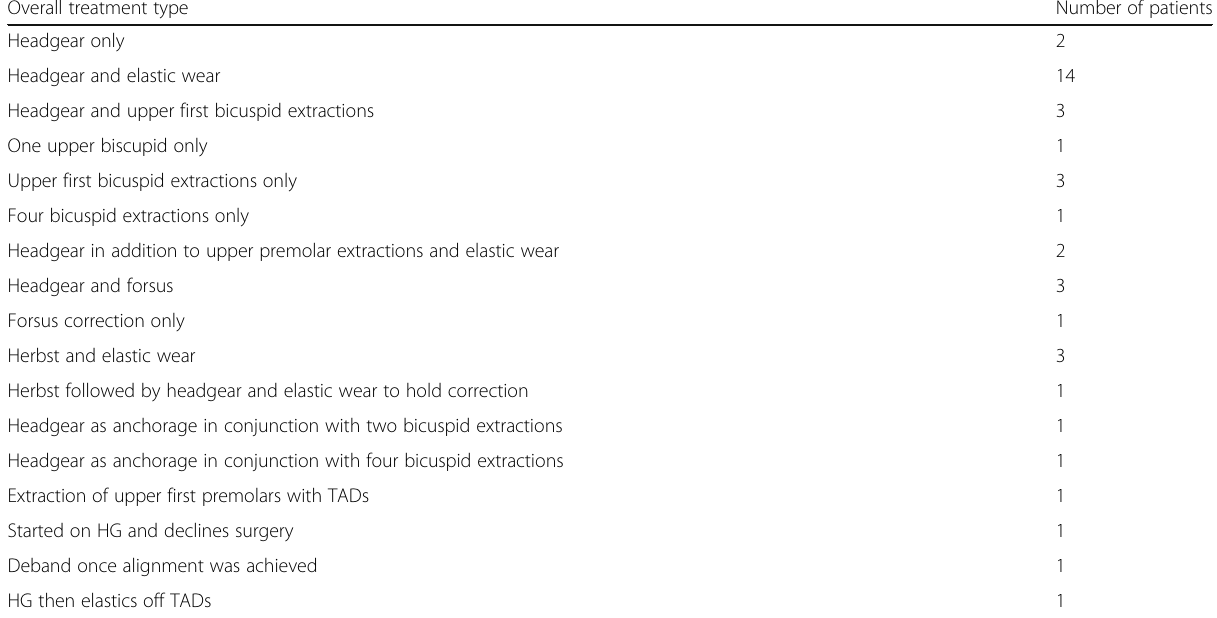
Table 2 Final treatment plan in the non-surgical treatment group Overall treatment type Number of patients